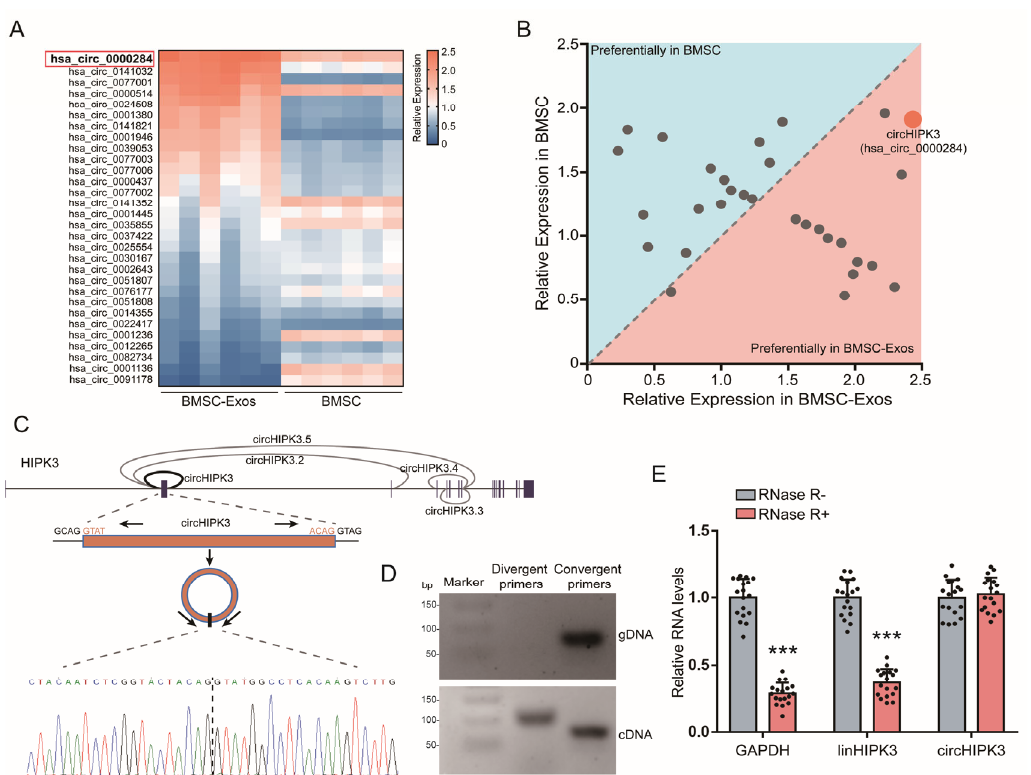
Figure 2. CircHIPK3 was highly expressed in BMSC-Exos. ( A ) Heatmap of highly expressed circRNAs in BMSCs and BMSC-Exos. The color from blue (low) to red (high) represents expression levels of circRNAs. Each row in the map represents a sample and each column represents a gene. The red box represents circHIPK3 (circBase name: hsa_circ_0000284). ( B ) The relative levels of highly expressed circRNAs in BMSCs and BMSC-Exos. The relative expression in BMSCs (Y-axis), against those in BMSC-Exos (X-axis). ( C ) Schematic presentation of circHIPK3 location and the junction site sequence. ( D ) Agarose gel electrophoresis analysis of circHIPK3 PCR products of divergent primer and convergent primer. cDNA: complementary DNA, gDNA: genomic DNA. ( E ) The RNase R digestion resistance test confirmed the stability of circHIPK3 ( n = 18). *** p <